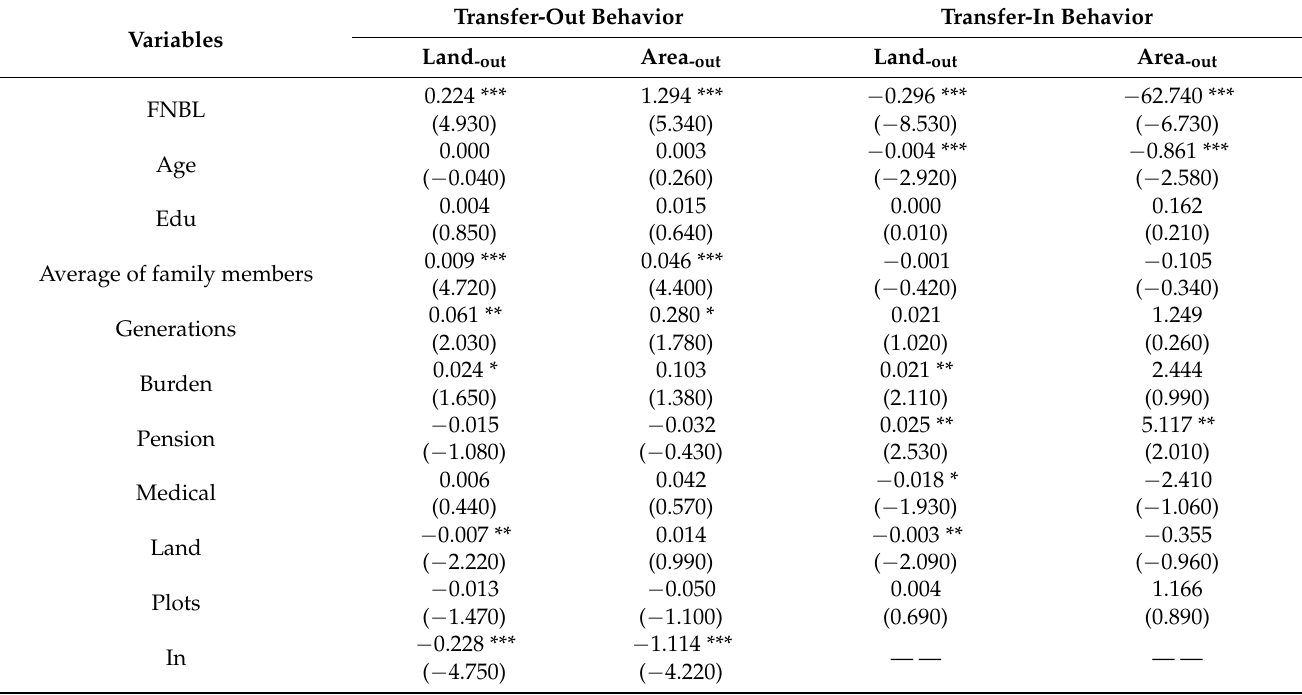
Table 3. The impact of off-farm employment on farmland